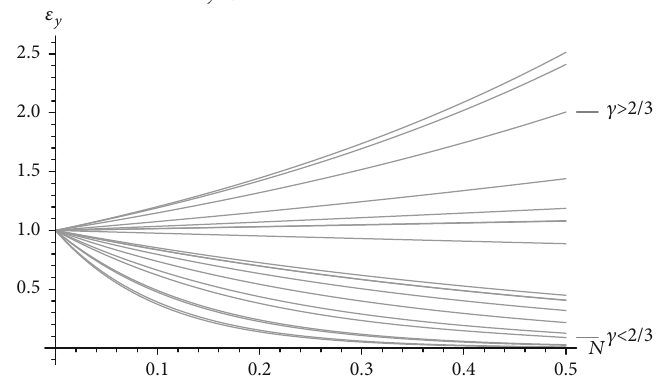
Figure 5: Shows the variation of ϵ against N showing that Q ð x = 0, y → 1 Þ is a stable fi xed point for γ < 2/3 . y